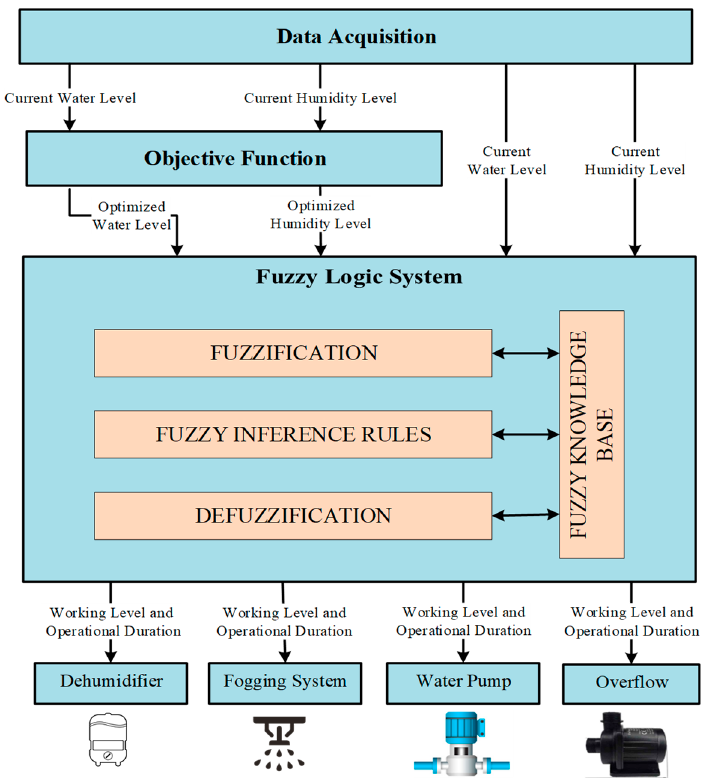
Figure 4. The general fuzzy logic control module for the proposed optimization based hydroponics model flowchart.